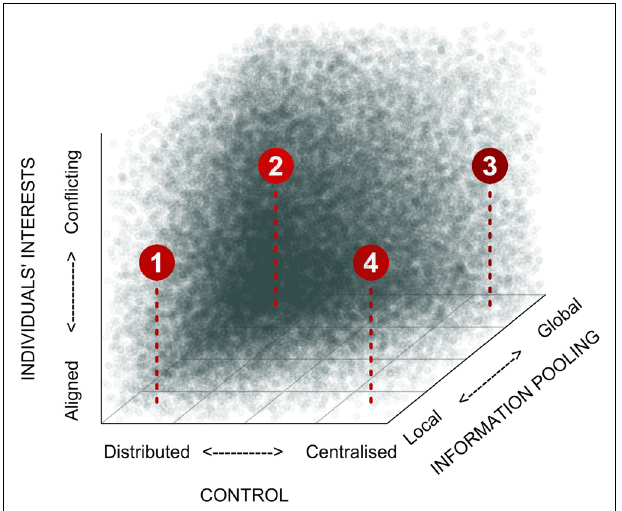
FIGURE 1 | Categorization of different forms of collective decision-making. Social settings can differ dramatically with respect to how skewed control is, the scale over which information is pooled, and the potential for conflicts of interests. Shading indicates the expected stability of collective decision-making processes within this parameter space. (1) Self-organization (examples: collective movements in bird flocks, fish shoals, ungulate herds, locust swarms; organization and division of labor in social insects or bacterial biofilms); (2) Democracy (examples: various human groups, certain primate groups), (3) Informed autocracy (examples: hierarchical animal societies, such meerkats or wolves; also certain primate groupings, and human military organizations). (4) “ Blind” autocracy (few examples from natural systems; unlikely to remain stable over evolutionary